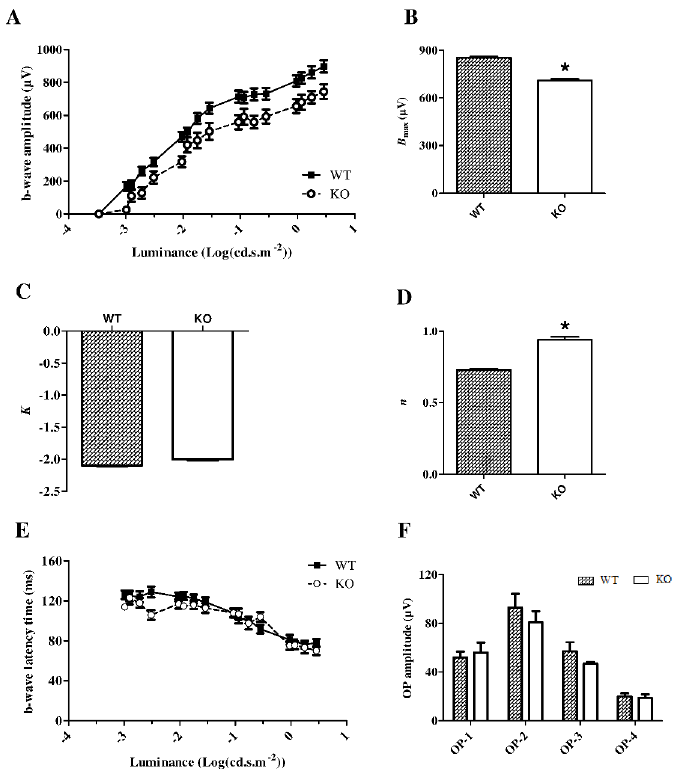
Figure 3. Scotopic b-wave characteristic in WT and Fmr1 KO mice. Retinal function was evaluated using ElectroRetinoGram (ERG). ( A ) Serial responses to increasing flash stimuli ( 2 3.47 log(cd.s.m 2 2 ) to 0.6 log(cd.s.m 2 2 )) were obtained for WT and Fmr1 KO mice under dark-adapted conditions (n=20 for WT and n=17 for Fmr1 KO). ERG response ( m V) was plotted against light intensities to obtain the b-wave sensitivity curve. In Fmr1 KO mice, the b-wave sensitivity curve is slightly collapsed compared to WT mice. The b-wave sensitivity curve was then fitted to calculate ( B ) the saturated b-wave amplitude ( B max ), ( C ) the K parameter (intensity providing half saturation) and ( D ) the n parameter (representing the b-wave sensitivity curves slope). In Fmr1 KO mice, B max is significantly decreased by 20%, the n parameter is significantly increased by 29%, whereas K parameter remained unchanged compared to WT mice. ( E ) b-wave latency and ( F ) oscillatory potential (OP) amplitude were not different between groups. Data are presented as Mean 6 SEM. Student’s t test, *p , 0.05.